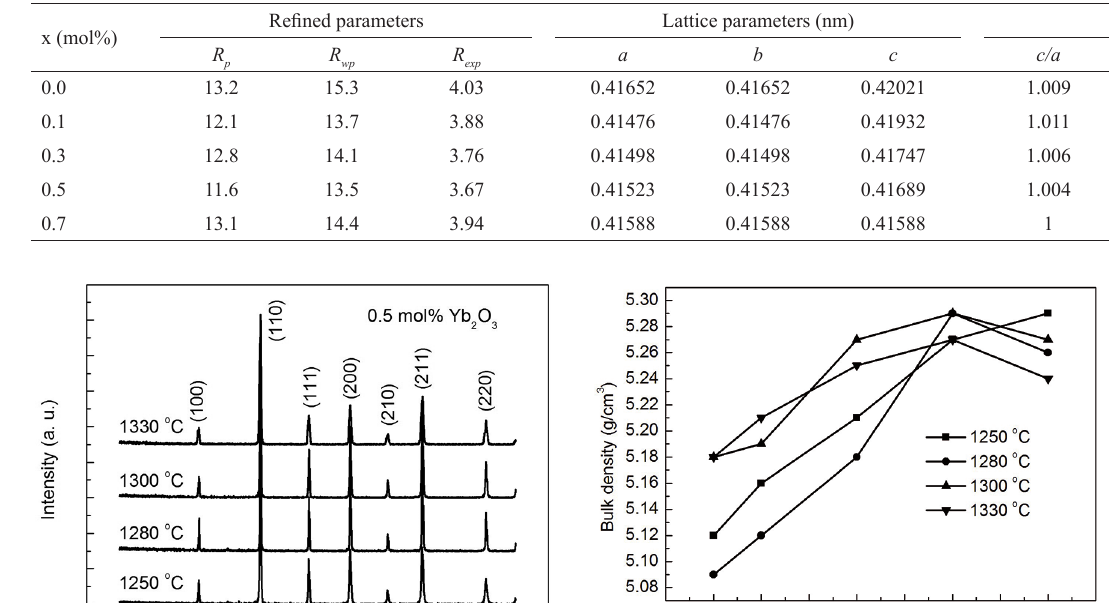
O + BZT ceramics 2 3 10